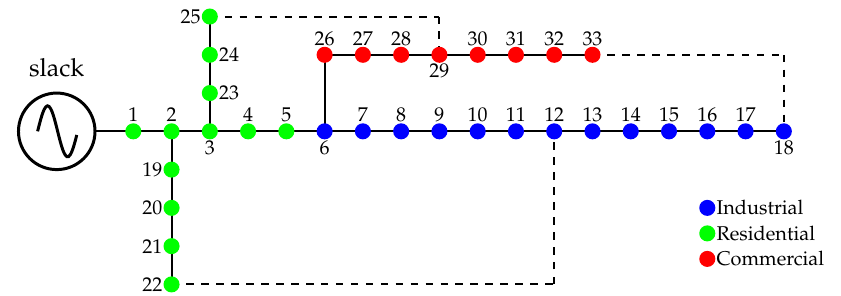
Figure 2. Electrical diagram of the IEEE 33-node radial test system.